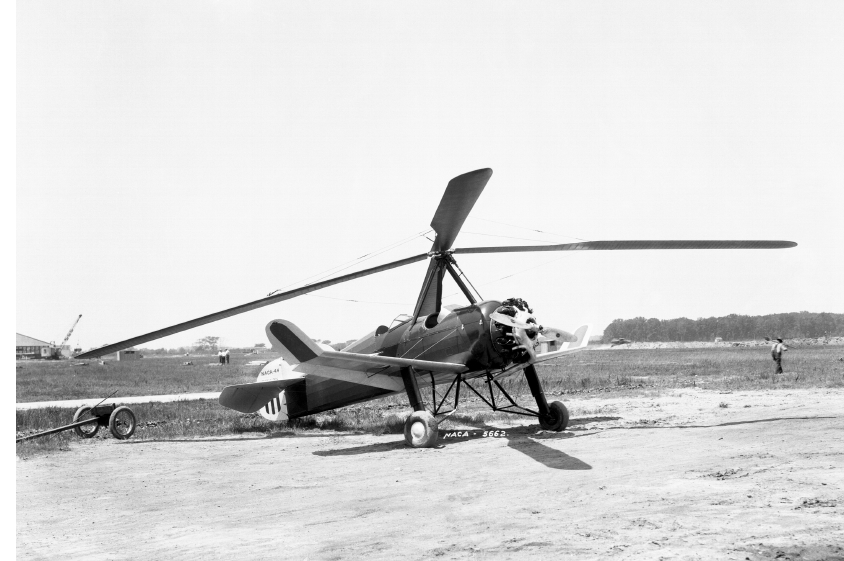
Figure 1. The picture above (public domain) shows a PCA-2 autogiro built in the United States by Pitcairn under license of the Cierva Company. This unit was used by the National Advisory Committee for Aeronautics (NACA) for research purposes on rotor systems (c.f.